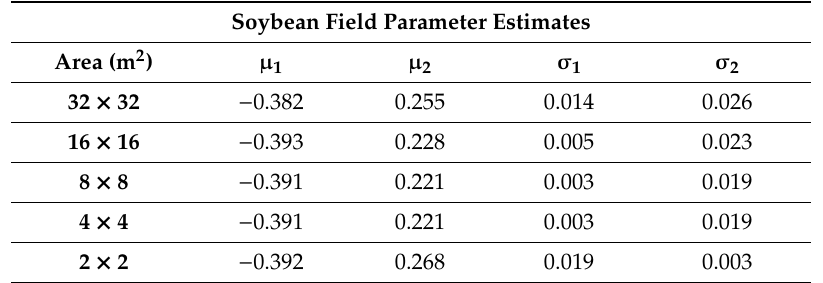
Table 3. Representative FMM parameter estimates for a soybean field. μ 1 and μ 2 correspond to the locations of “ground” and “plant” distributions, respectively. σ 1 and σ 2 are respective variances. The difference between μ values is calculated to estimate height, irrespective of the absolute value of μ values. Here, negative height values result due to the global average height being set to zero.